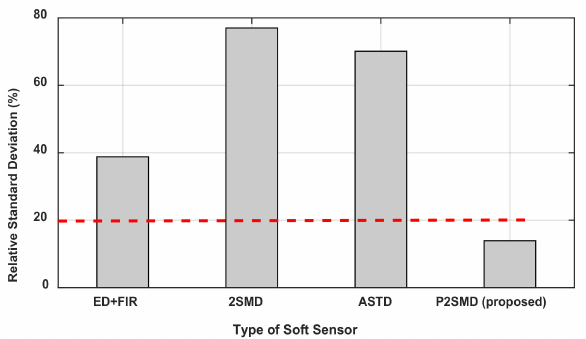
Figure 5. The maximum value of the relative standard deviation (%) for each